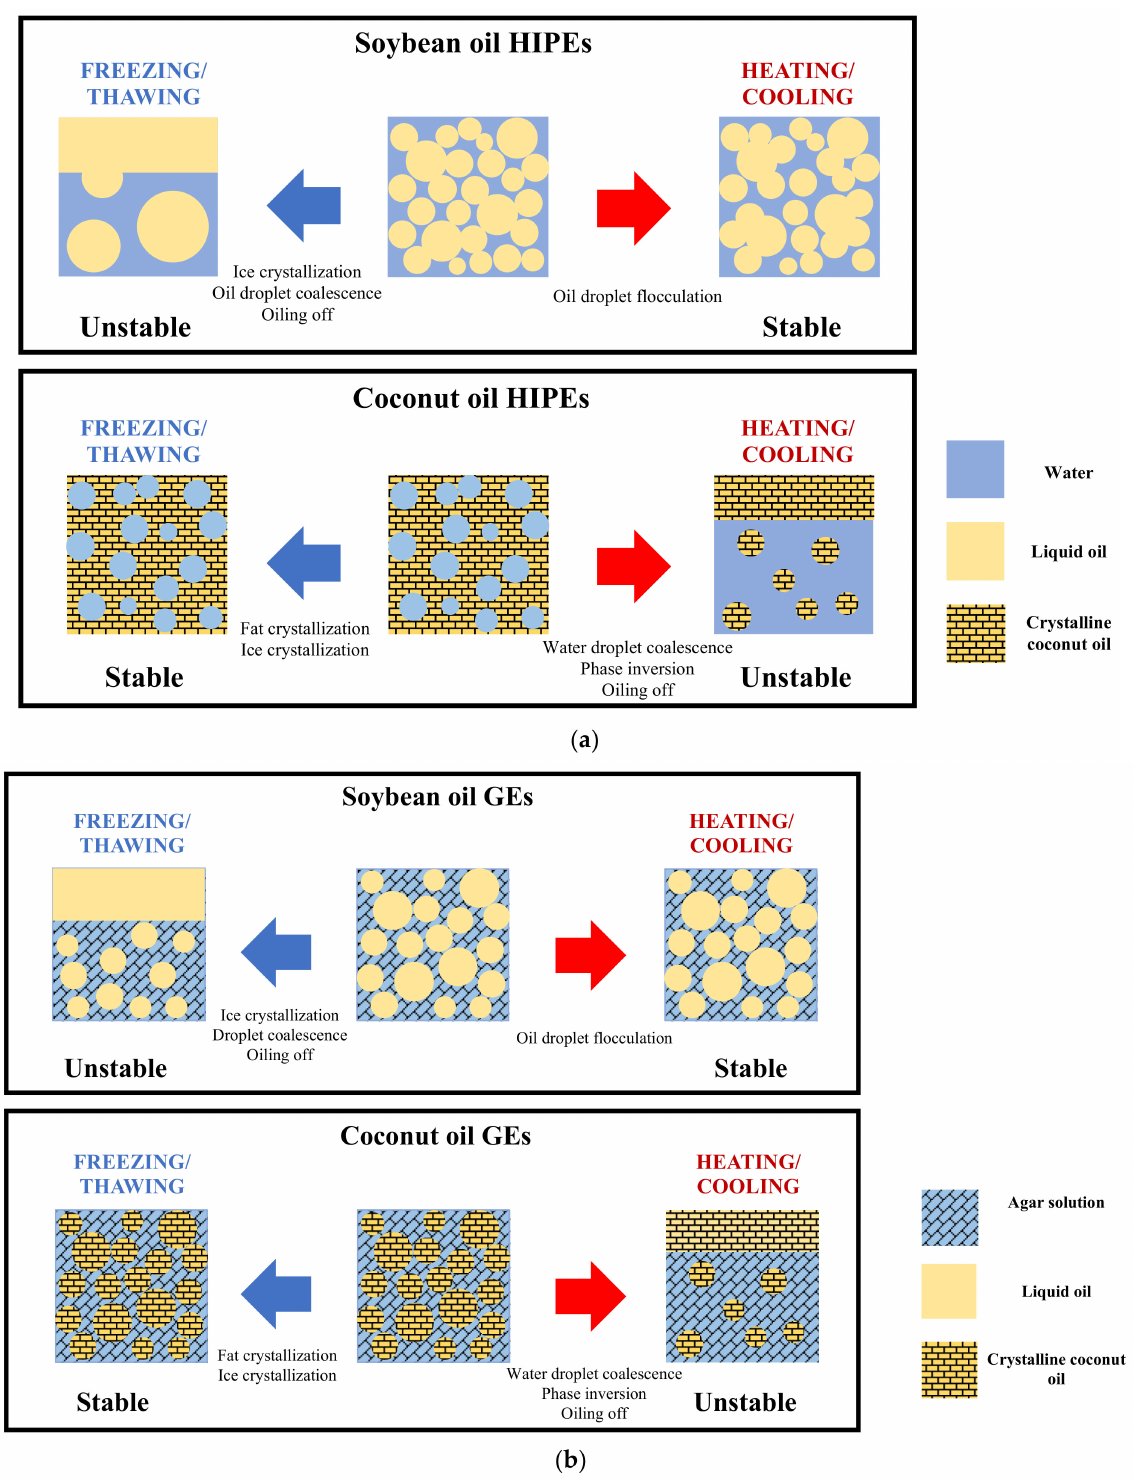
Figure 14. ( a ) Schematic diagram of the behavior of soybean and coconut oil HIPEs after freezing and heating. ( b ) Schematic diagram of the behavior of soybean and coconut oil gelled emulsions after freezing and